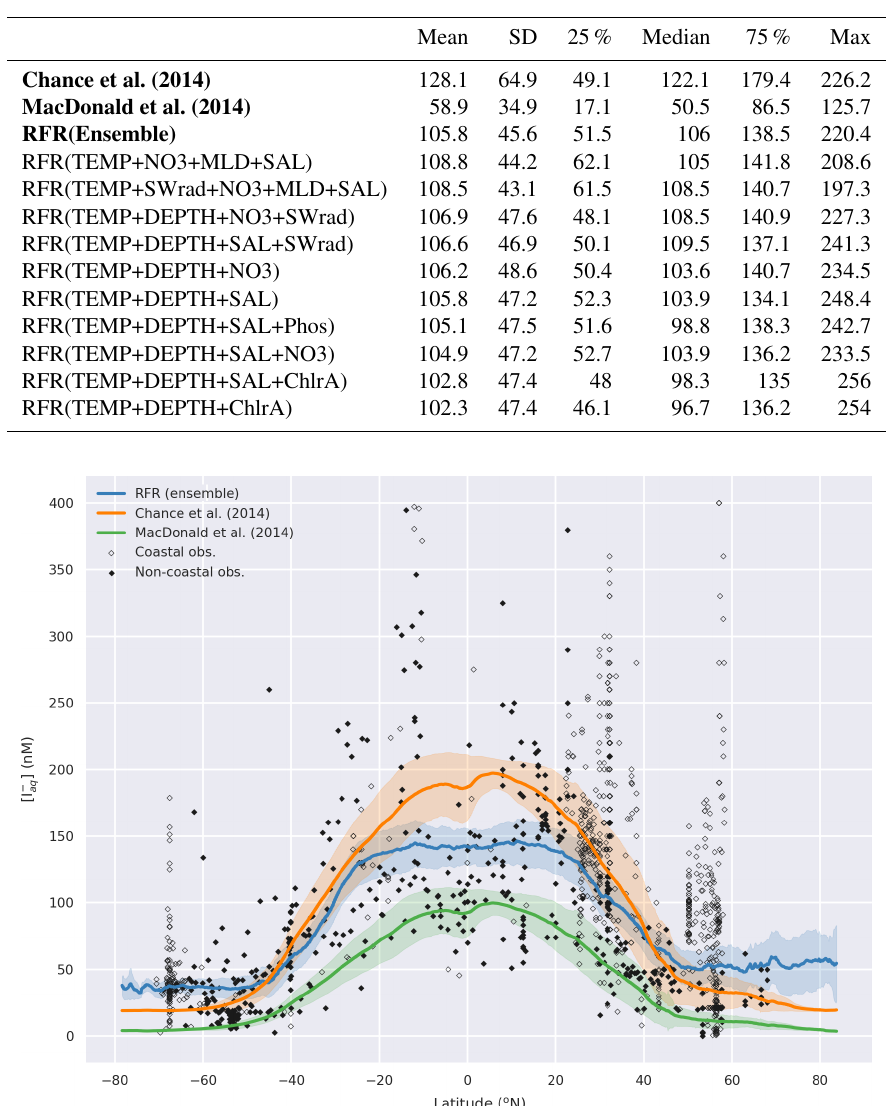
Table 4. Statistics on predicted global annual sea-surface values from new and existing parameters at a horizontal resolution of 0 . 125 ◦ × 0 . 125 ◦ . Existing parameterisations (Chance et al., 2014; MacDonald et al., 2014) and the ensemble prediction are shown in bold.